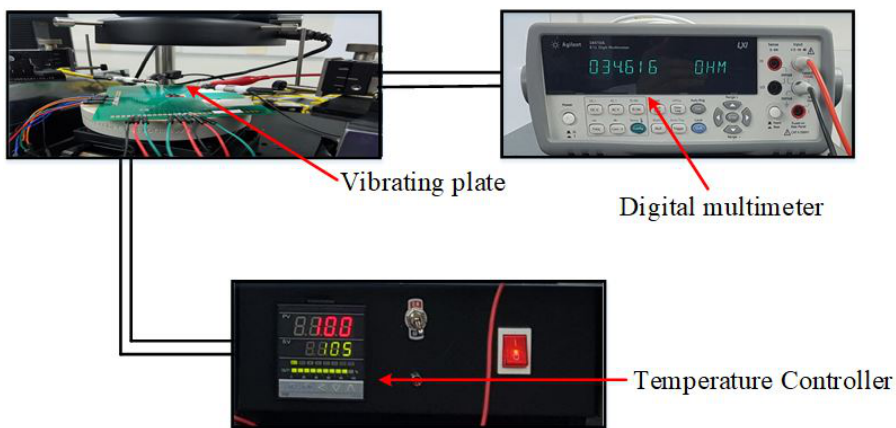
Figure 12. Block diagram for measuring temperature sensor resistance vs. ambient temperature.